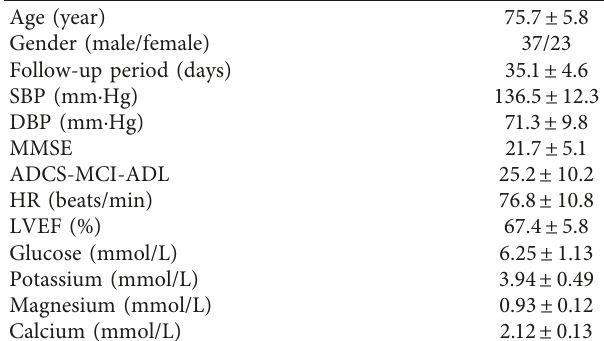
Table 1: Demographics and baseline characteristics of patients.